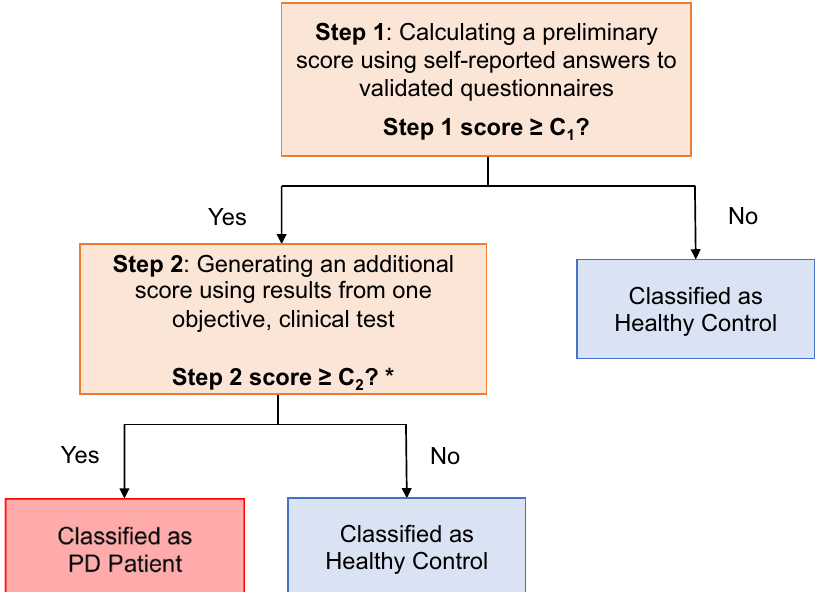
Fig. 4 Decision tree diagram of Model 2. C 1 and C 2 are optimal cut-off values of Step 1 score and Step 2 score, respectively. * For select Step 2 tests (e.g., smell test), if the mean score for healthy controls (HC) is larger than that of subjects with Parkinson ’ s disease (PD), the decision criterion will be “ Step 2 score ≤ C 2 ? ” .